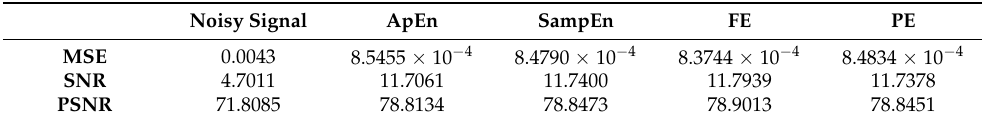
Table 2. MSE, SNR, and PSNR of synthetic data experiment.